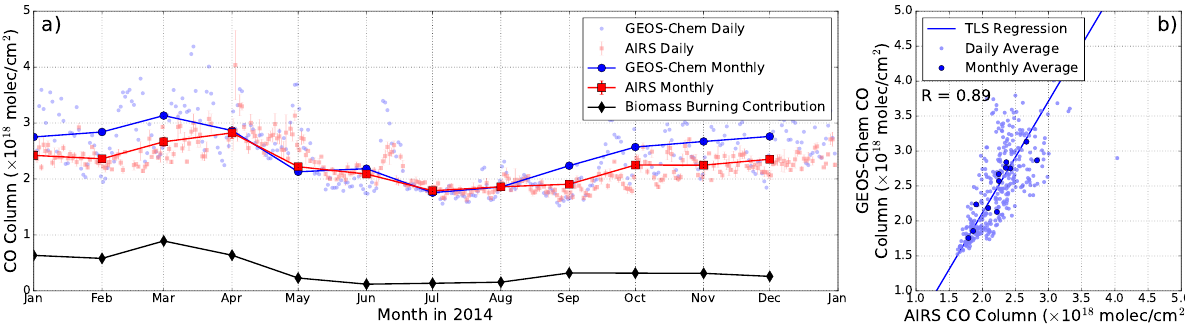
Figure 3. (a) Time series of the GEOS-Chem simulation and AIRS satellite observations of CO total columns over Hong Kong. The contribution of atmospheric CO originating from biomass burning sources is also shown for reference. (b) Comparison of GEOS-Chem simulation and AIRS satellite observation of CO total columns over Hong Kong. Daily and monthly average data are shown. The total least squares regression line is calculated based on the monthly average data.